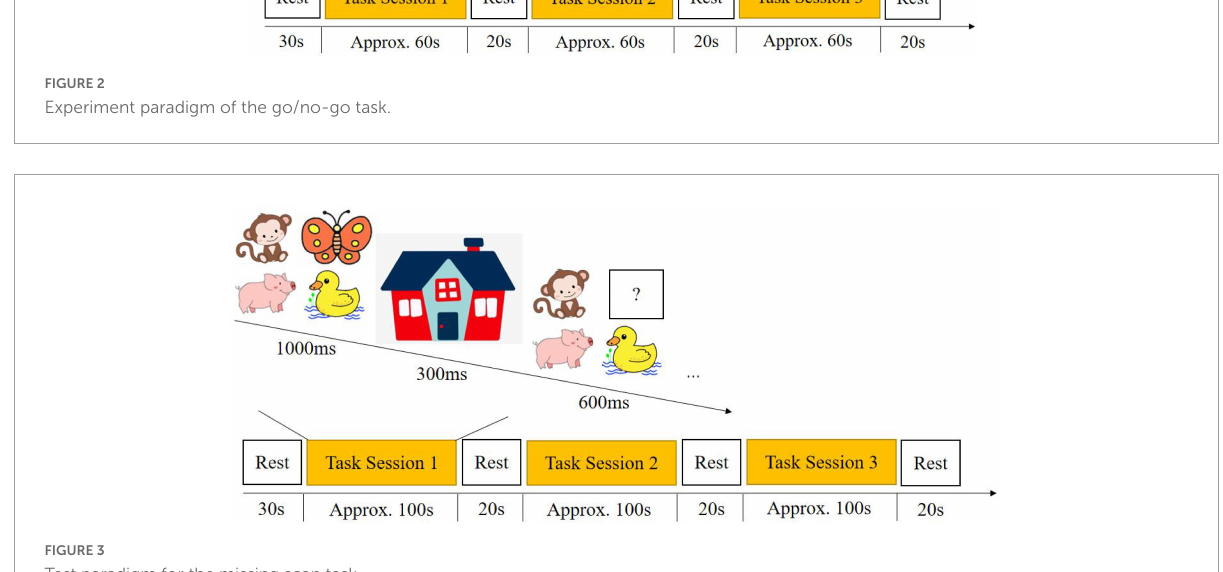
FIGURE3 Test paradigm for the missing scan